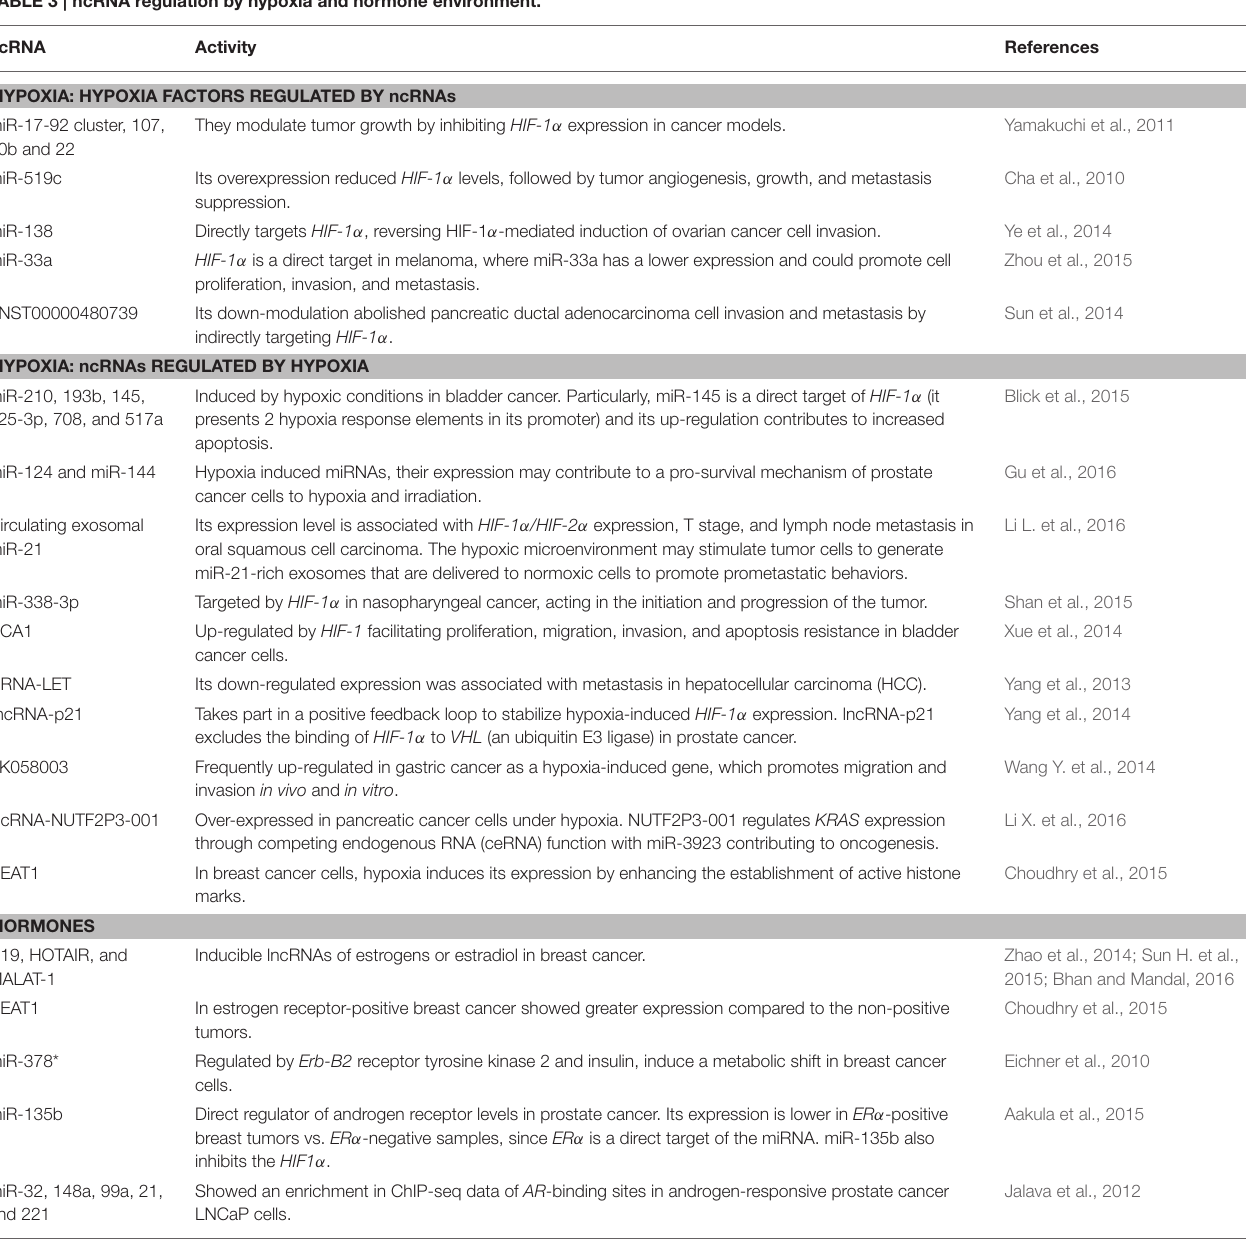
TABLE 3 | ncRNA regulation by hypoxia and hormone